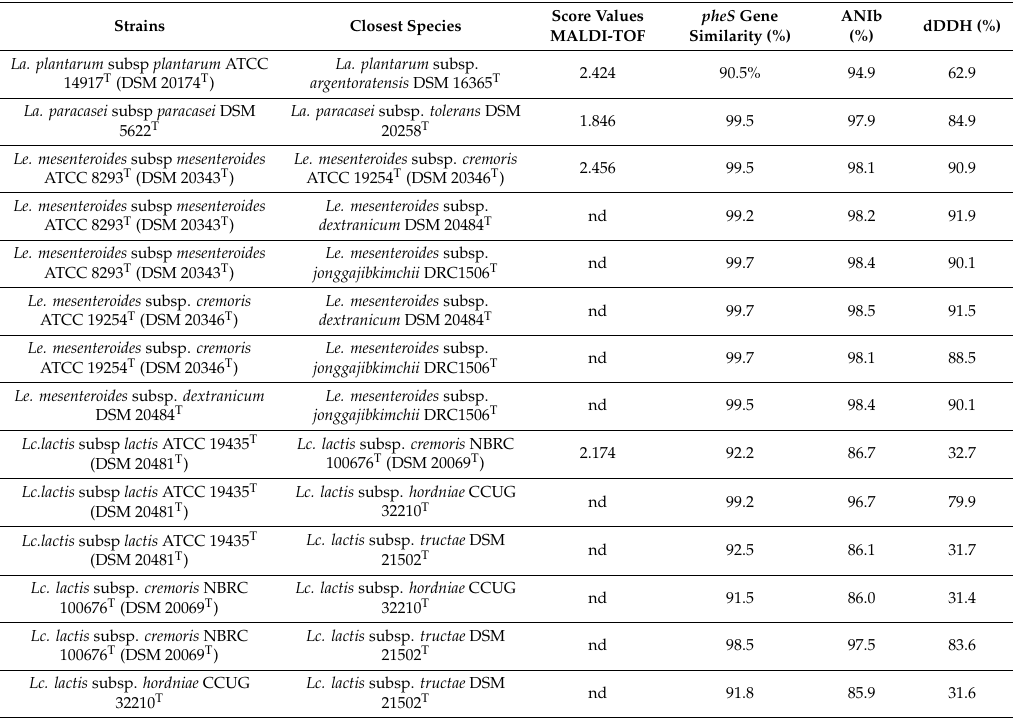
Table 2. Results of the comparison of the type strains of subspecies from di ff erent species of LAB identified in this study obtained with di ff erent